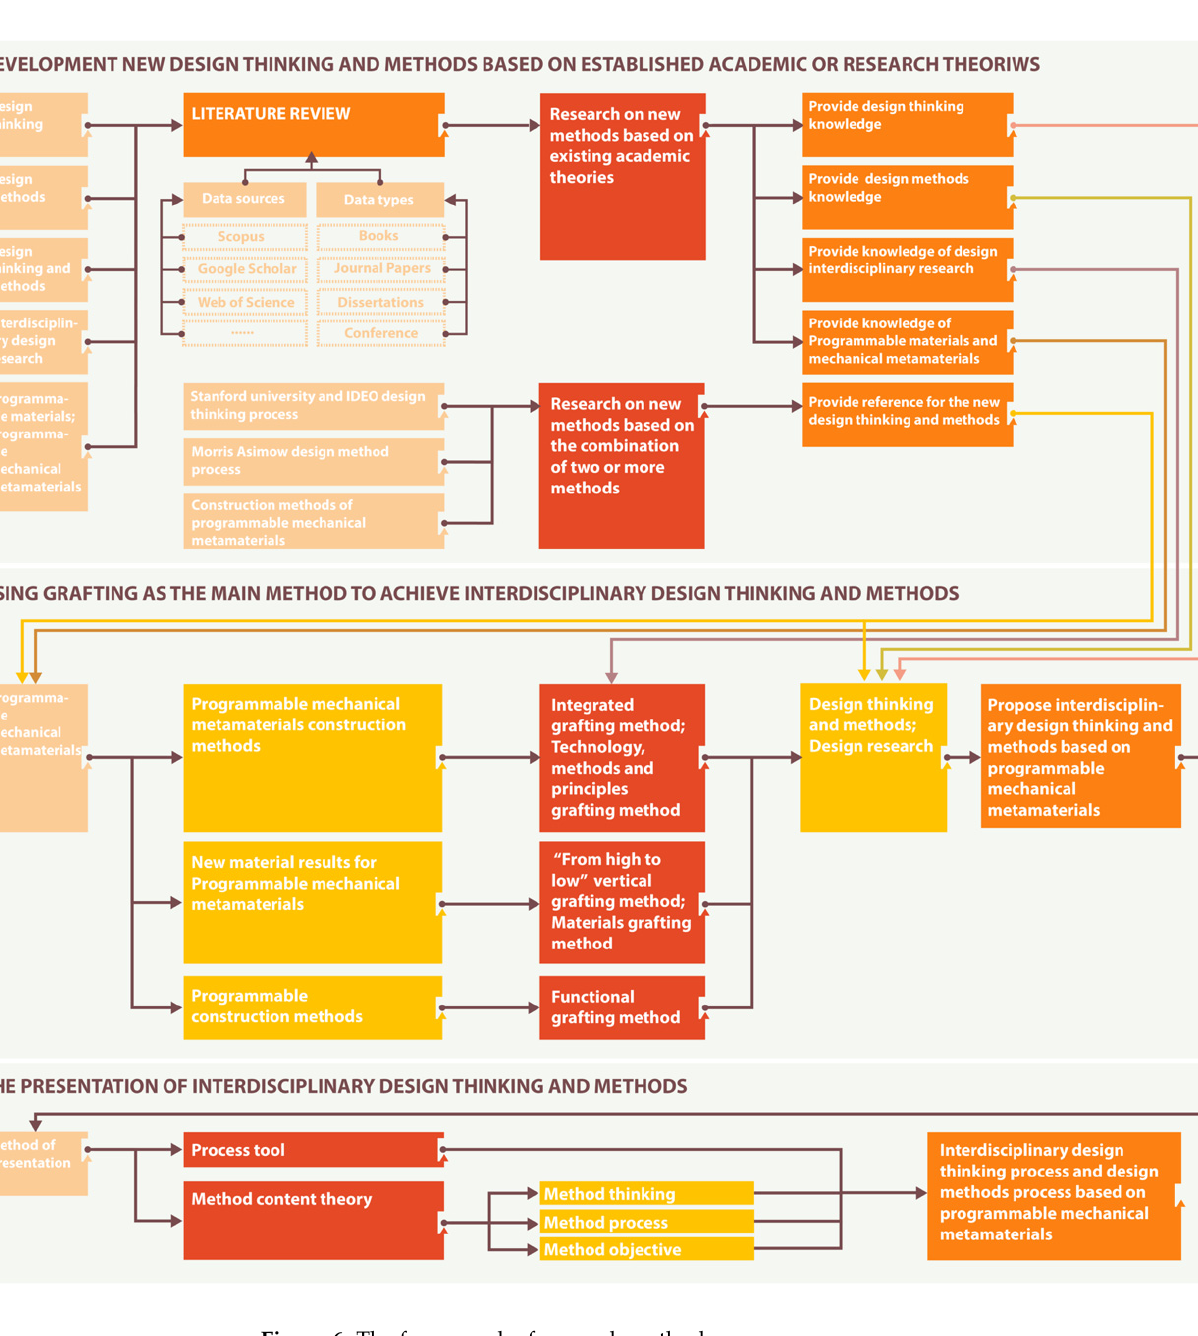
Figure 6. The framework of research methods.